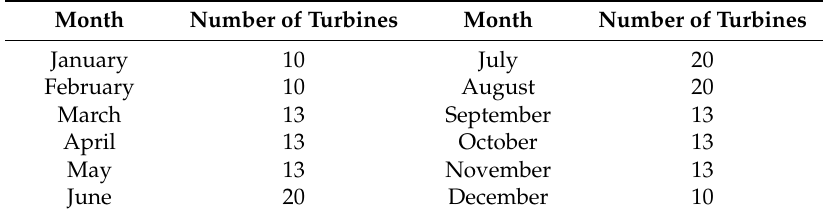
Table 8. Number of Boreas 150 turbines to satisfy the total electricity demand in the sector of Cabildo, by month.